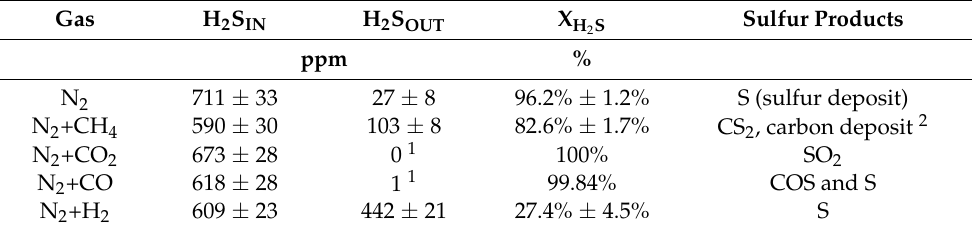
Table 3. H 2 S conversion in nitrogen and two-component plasma. Gas H 2 S IN H 2 S OUT X H